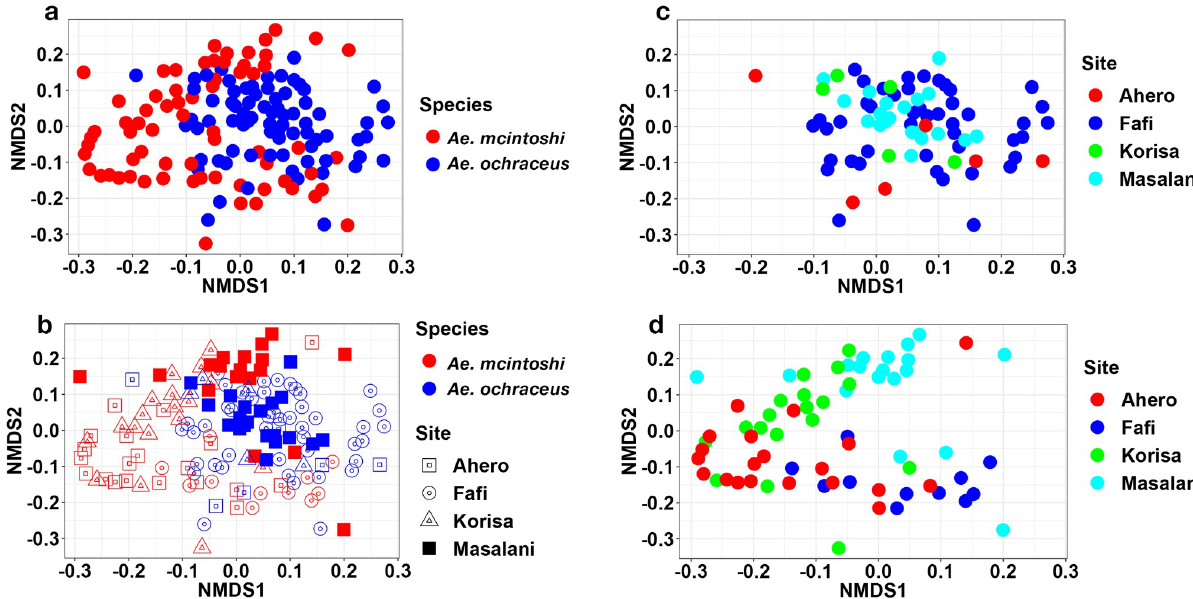
Fig 6. Nonmetric Multidimensional Scaling (NMDS) ordination displaying the microbial communities of Aedes mcintoshi and Aedes ochraceus . (a) both species from all sites pooled, (b) both species by study site, (c) Ae . ochraceus by study site and (d) Ae . mcintoshi by study site.